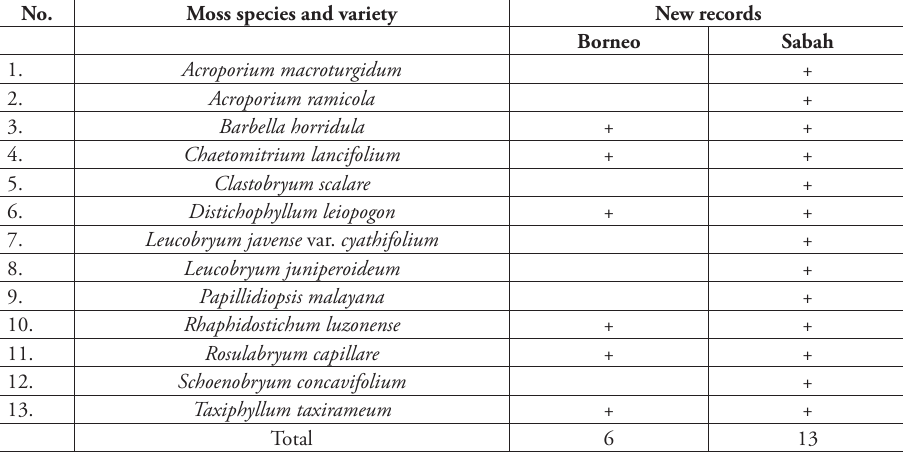
Table 3. New records of mosses to Borneo and Sabah.